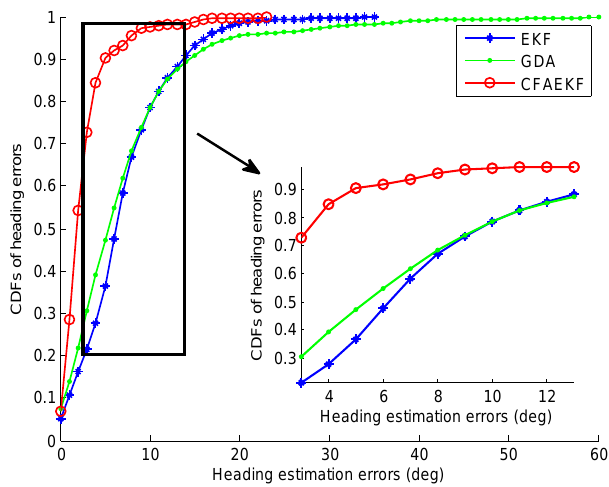
Figure 14. CDFs of errors of heading